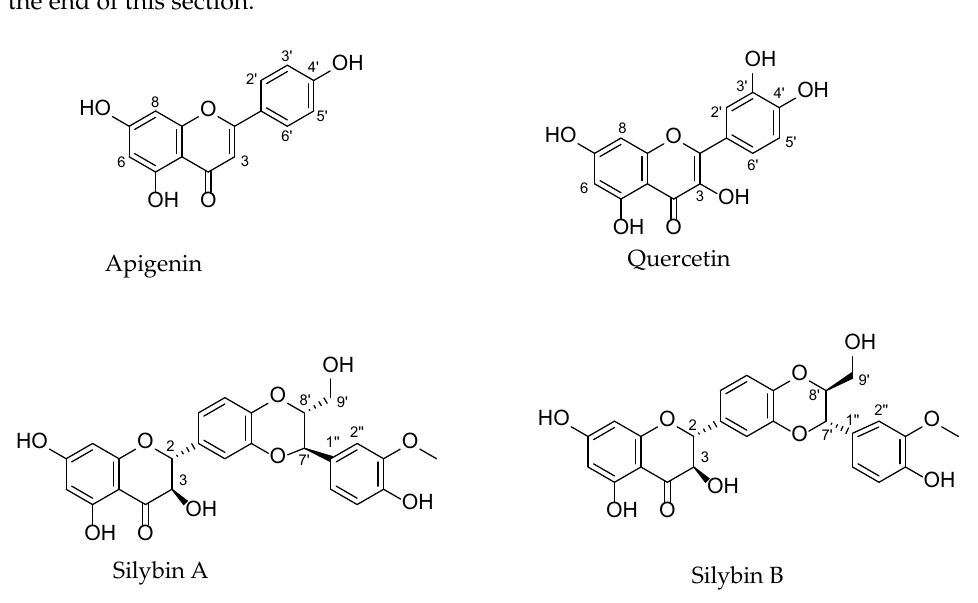
Figure 2. Chemical structures of apigenin, quercetin, and silybin A/silybin B (the structures were designed using the ChemDraw ® v.16.0 software).